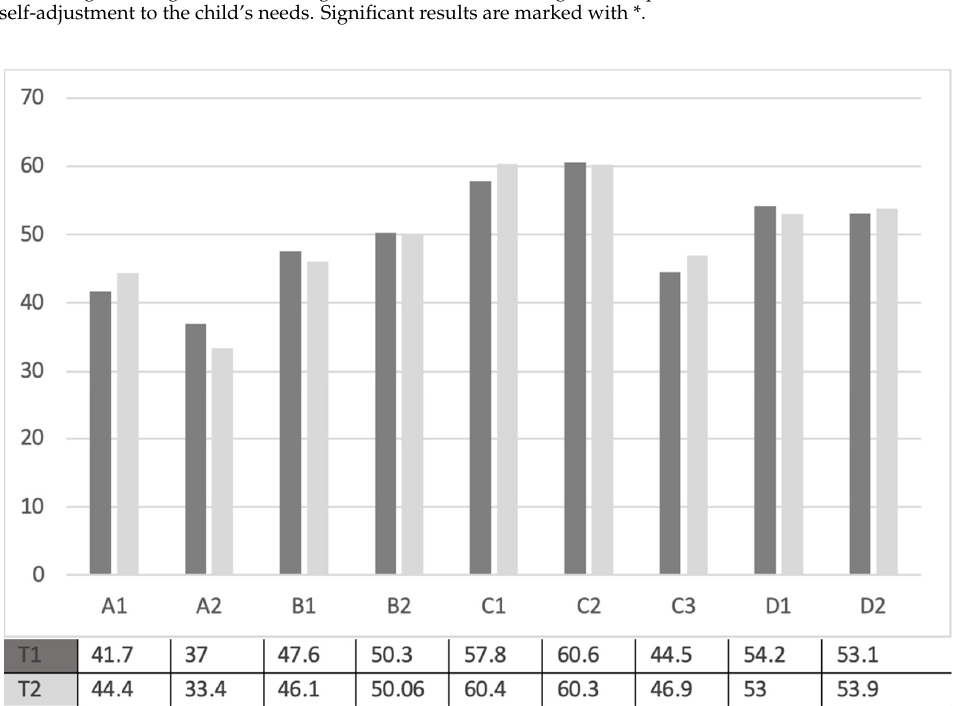
Figure 1. Configuration of the perceived maternal role competence in T1 and T2 (average indicator scores) ( n = 104). Table 2. Comparison between the Q-sort scores obtained by the sample and the maternal role competence criteria at T1 (paired sample t -test) ( n = 104).